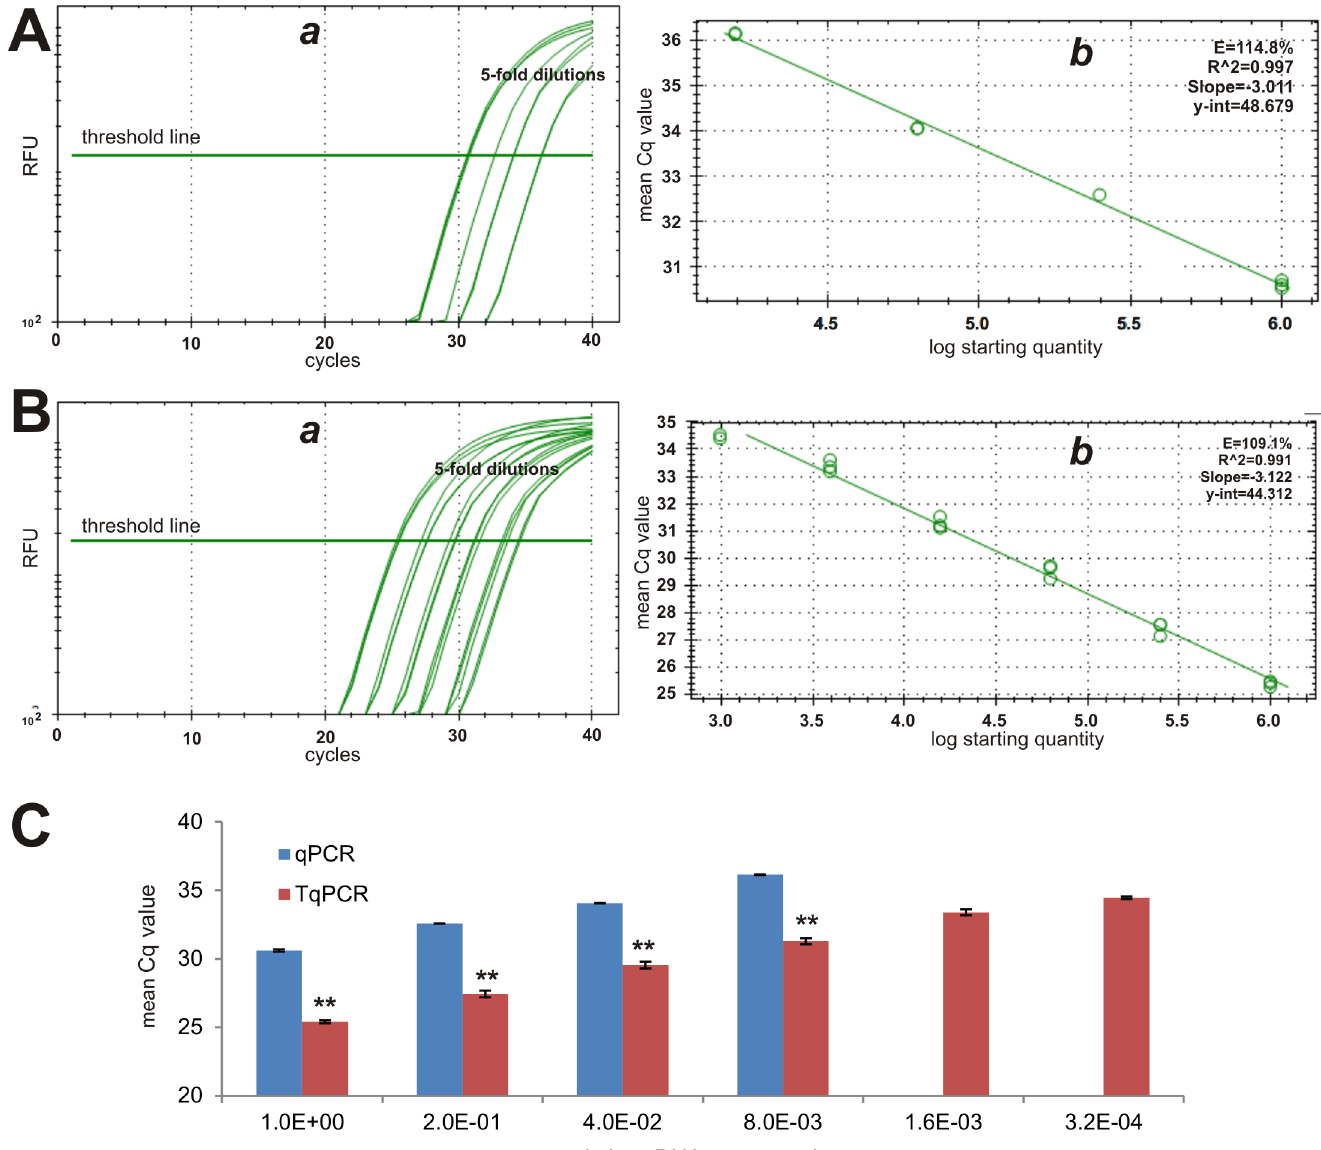
Fig 4. Comparative analysis of less abundant reference gene Hprt1 expression detected by conventional qPCR and TqPCR. The cDNA sample was prepared from the exponentially growing iMEF cells and was 5-fold serially diluted for PCR amplification, as described in Fig 2. Primers specific for mouse Hprt1 were used to detect its expression with the conventional qPCR (A) and TqPCR (B) protocols using CFX-Connect qPCR unit (Bio-Rad). The qPCR SYBR Green fluorescence history vs. cycle numbers ( a ) and the qPCR efficiencies of Hprt1 ( b ) were analyzed and presented. The mean Cq value comparison of the two procedures was further graphed (C) . Note that the qPCR protocol did not yield reliable results for the two most diluted cDNA samples. “ ** ” , indicating the Cq difference between qPCR and TqPCR groups is significant with p <